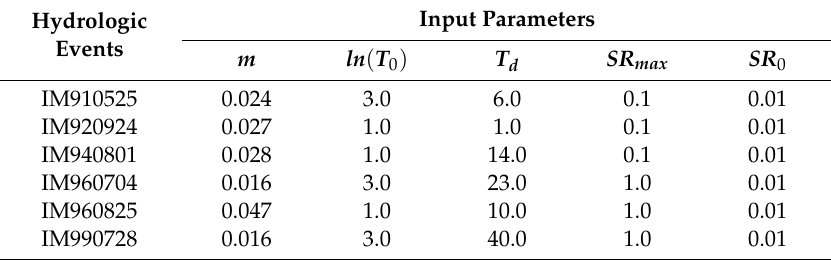
Table 5. Applied fixed input parameter sets in the Ieemokjung